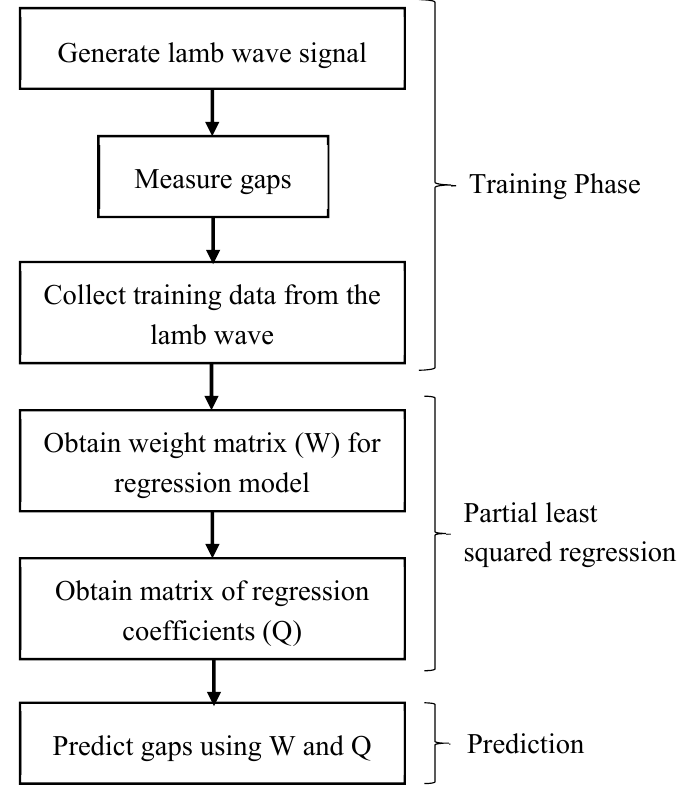
Figure 1. Flowchart to predict gaps using the training data from lamb waves.